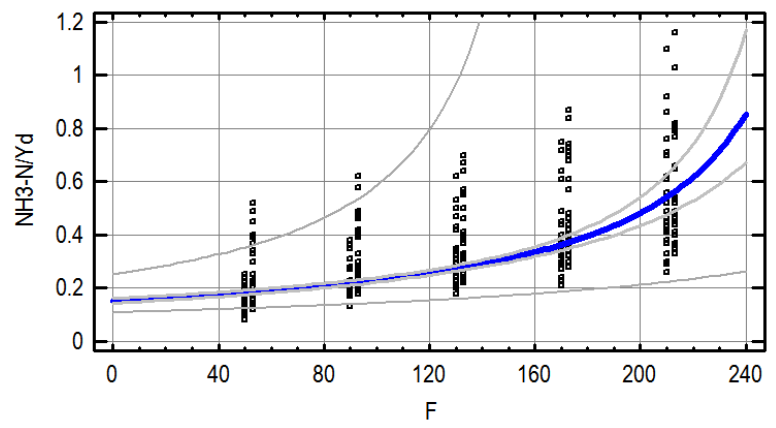
Figure 7. Observed and predicted yield-scaled NH 3 emissions (NH 3 /Yd, kg N·Mg − 1 ) depending on nitrogen doses (F, kg N·ha − 1 ) (R 2 = 48.0%, n = 320). A fairly close regression relationship was found between Ns and yield-scaled emis- sions of N 2 O and NH 3 (Figures 8 and 9). In both cases it was described with the exponen- tial model.